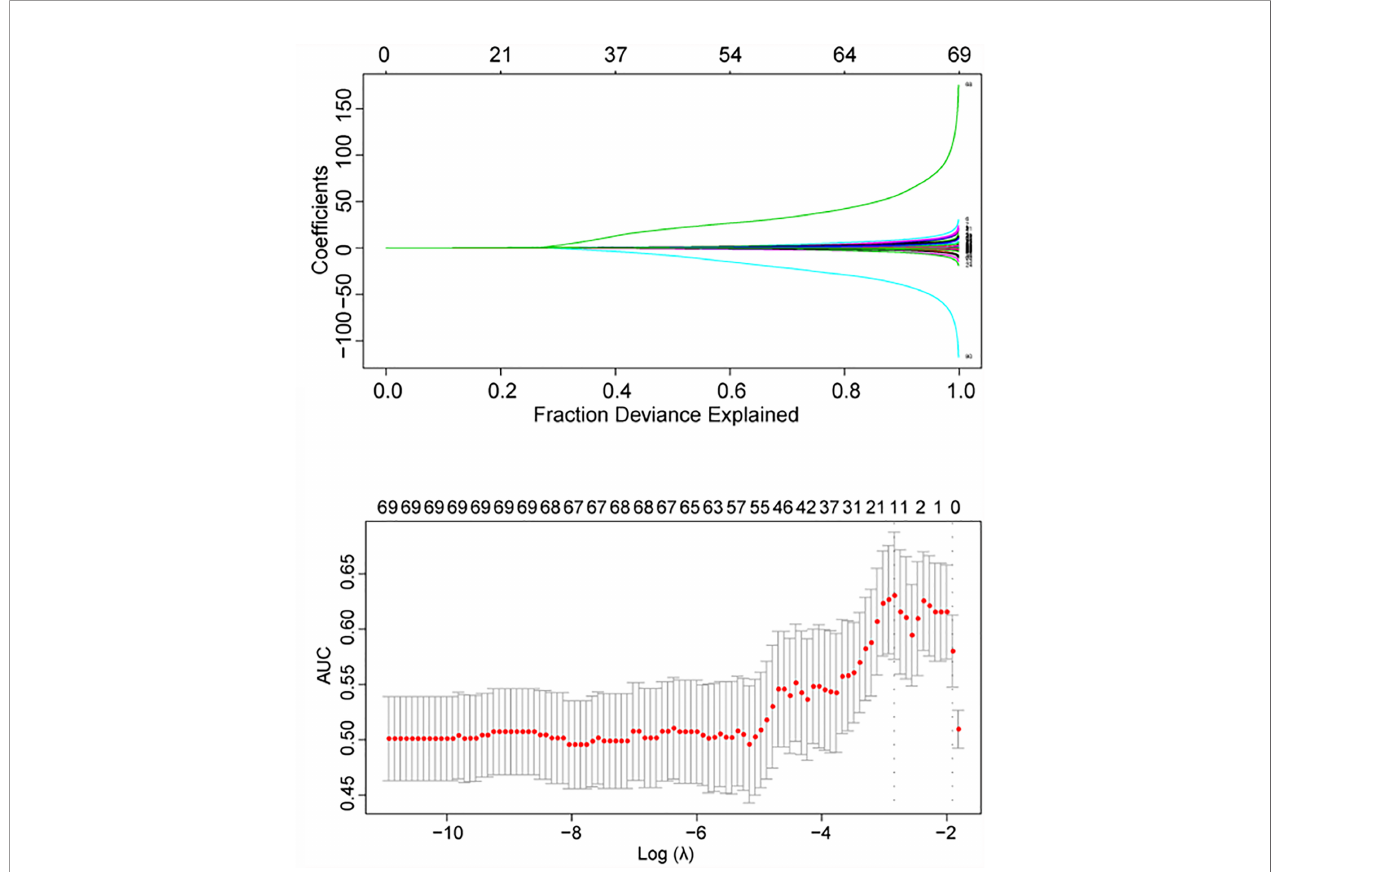
FIGURE 1 | LASSO regression analysis using 10-fold cross-validation. AUC, area under the curve.